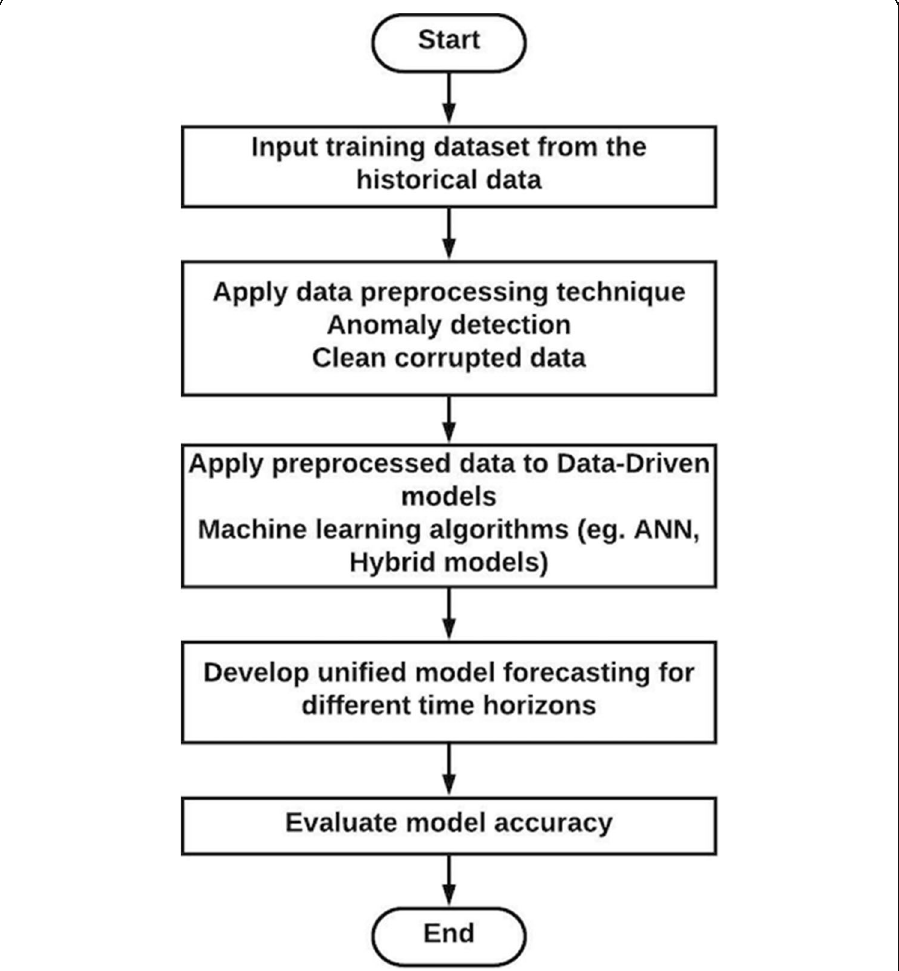
Fig. 1 Flowchart of forecasting process based on predictive data mining